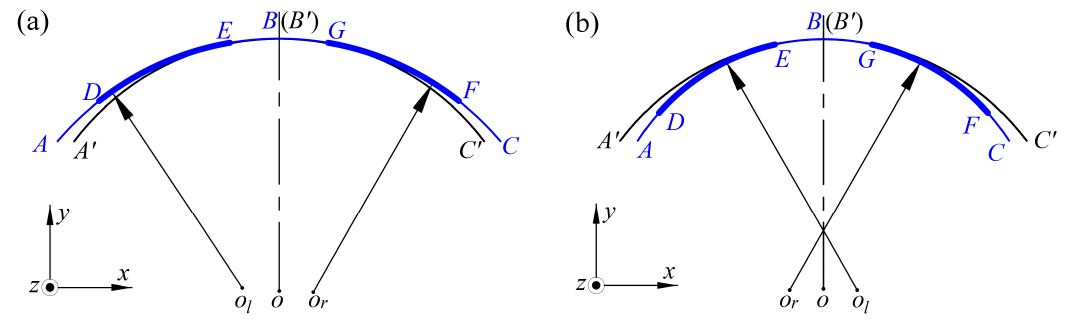
Figure 6. Schematic of the biarc curve-fitting method: ( a ) diamond roller is before the center, ( b ) diamond roller is past the center.